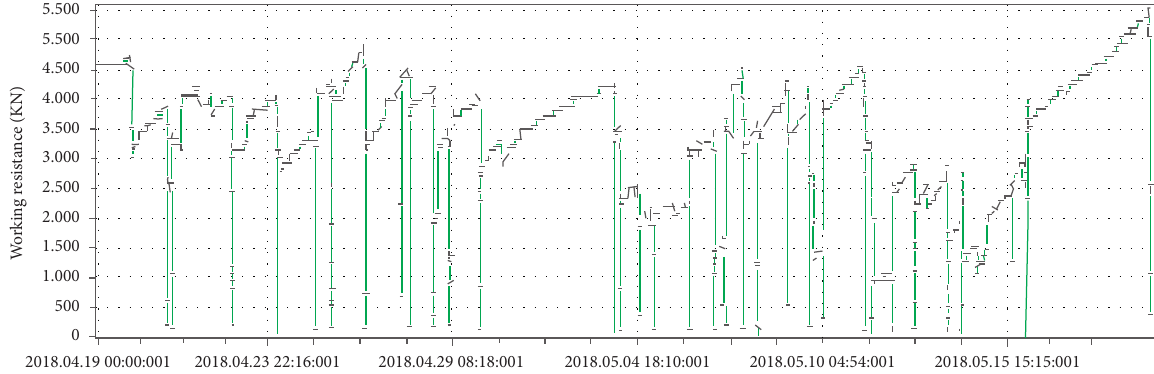
Figure 5: 1 #online monitoring of working resistance of extension support